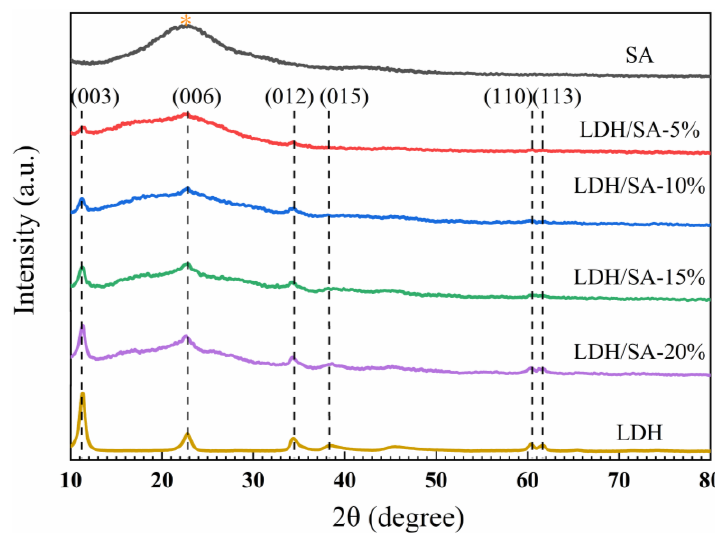
Figure 2. XRD patterns of the pure SA, MgAl-LDH and LDH/SA composites. Gels 2022 , 8 , x FOR PEER REVIEW